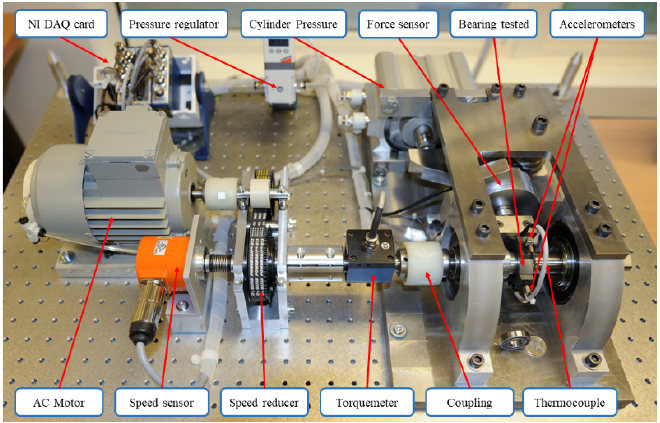
Figure 3. Experimental platform of bearing faults for the PHM2012 dataset [28].